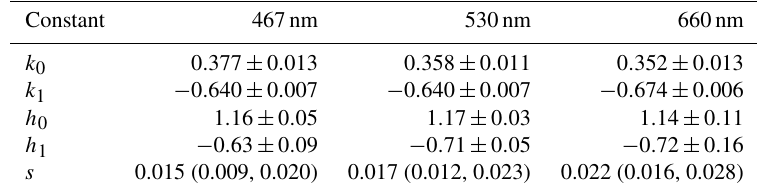
Table 5. Constant values given by Virkkula (2010) for Eq. (7). For parameter s min. and max. values are reported in parentheses.